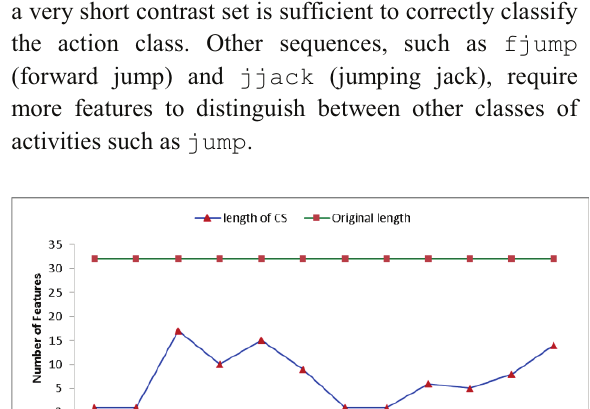
Table 3. Lengths of the discovered contrast sets of the Musk dataset.